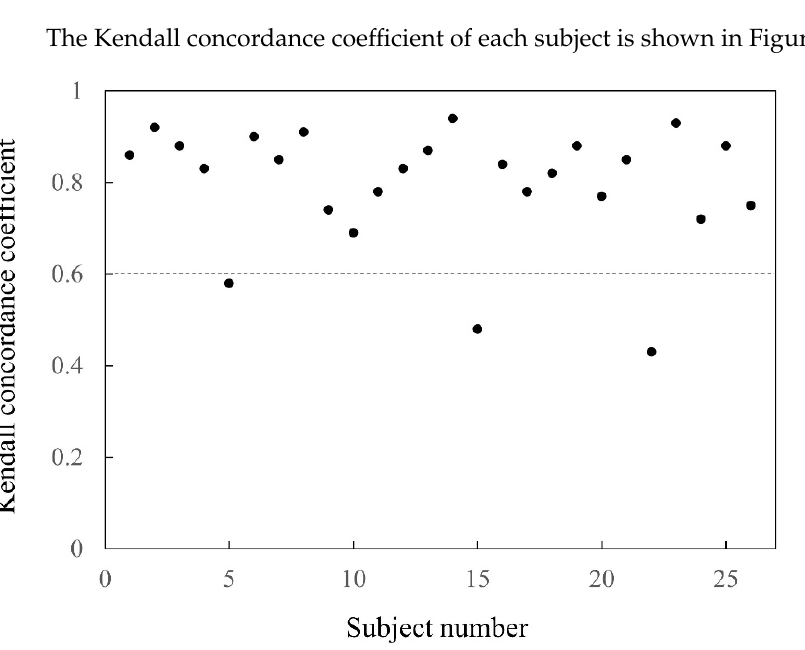
( b ) Figure 13. Normality test: ( a ) Subjective responses’ distribution of point 11; ( b ) Hypothesis test re- sults of each measuring point.